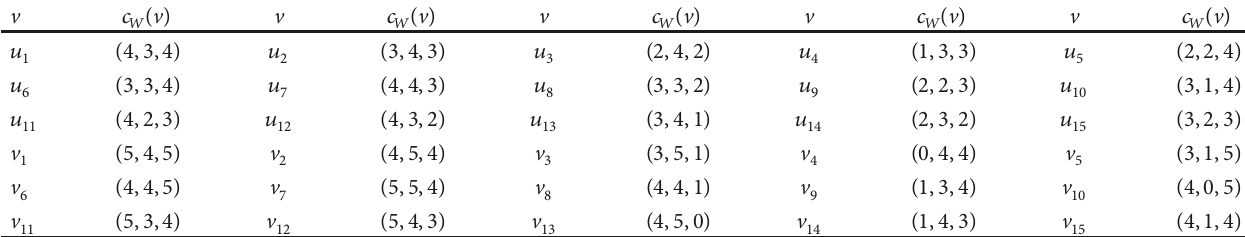
Table 14: The code 𝑐 𝑊 ( V ) of V with respect to 𝑊 = { V 4 , V 10 , V 13 } in 𝑃(15, 5)